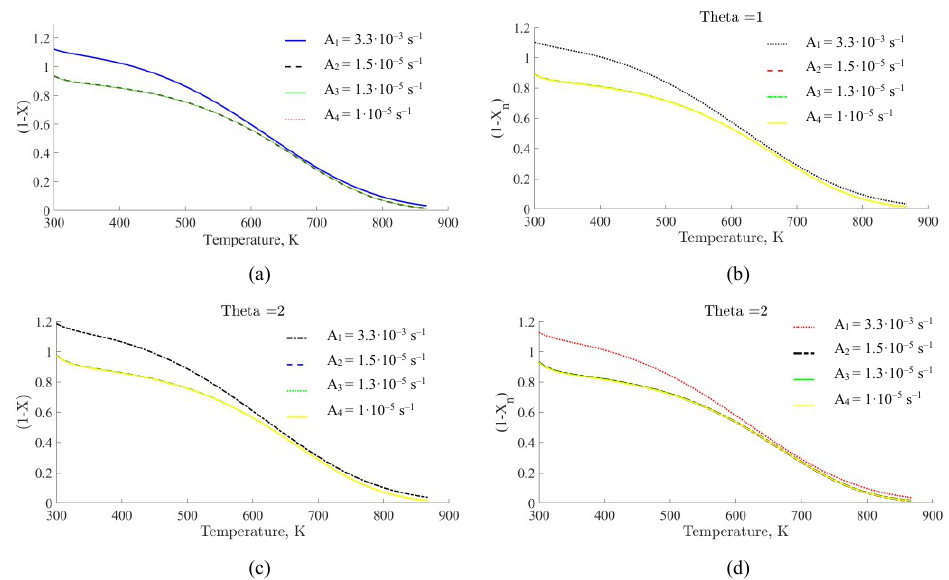
Fig. 2. The effect of frequency factor ( A ) (s −1 ) on the numerical results of bi-variant scheme for DAEM: (a) first order reaction ( θ = 1); (b) n th order reaction ( θ = 1); (c) first order reaction ( θ = 2); (d) n th order reaction ( θ = 2) ( η = 10 −9 kJ/mol, β = 0.0920, m = 10 °C min −1 and n = 0.11).